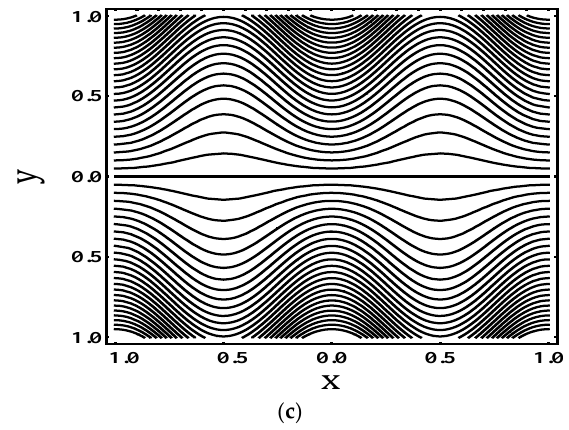
Figure 8. Streamline distribution for ( a ) U HS = − 1.0; ( b ) U HS = 0.0; ( c ) U HS = 1.0.